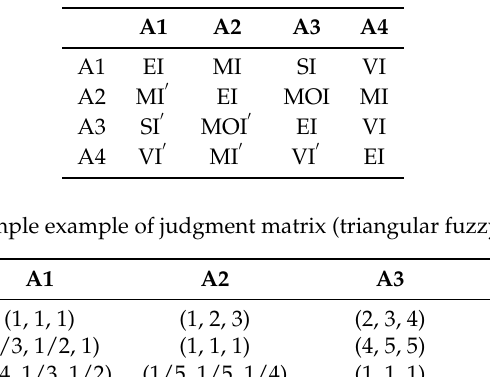
Figure 2. The hierarchical structure of a problem. Table 2. A simple example of judgment matrix (linguistic terms).